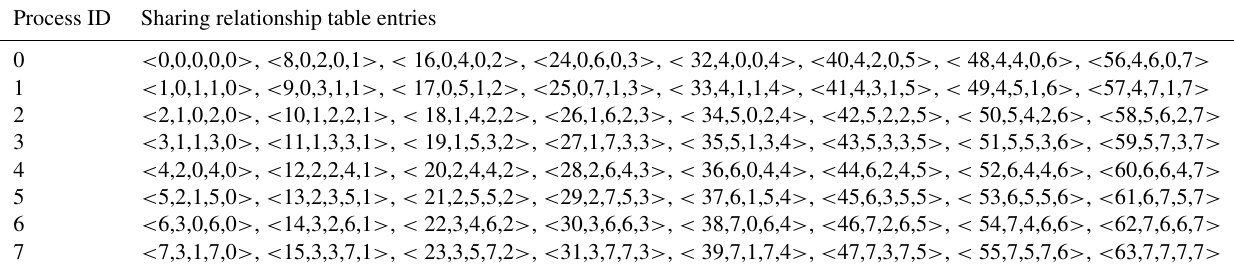
Table 6. The SRT entries distributed in the dst component model after rearranging the SRT in Table 4. Process ID Sharing relationship table